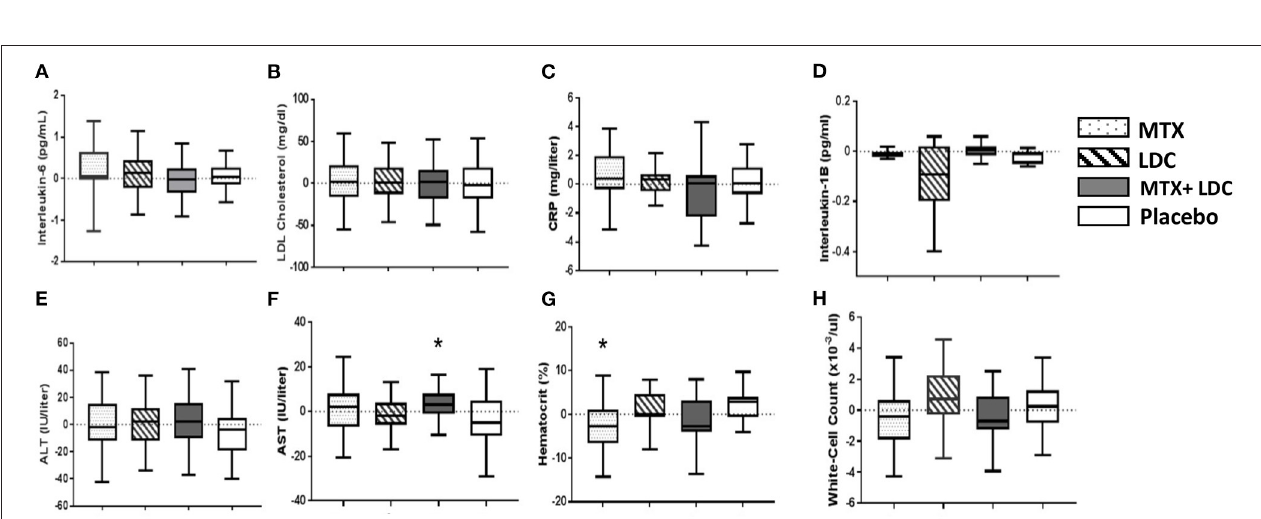
FIGURE 3 | Bar graphs showing the effects of low-dose methotrexate (MTX, dotted bar), colchicine (LDC, striped bar), the combination of MTX and LDC (gray bar), and placebo (white bar) on (A) . interleukin-6, (B) low-density lipoprotein [LDL] cholesterol, (C) hsCRP, (D) interleukin-1 β , hepatic enzyme levels (E) alanine aminotransferase [ALT] and (F) aspartate aminotransferase [AST], and hematologic measures (G) hematocrit level, (H) white-cell count. Data shown are the changes from study enrollment to 8 weeks after randomization. The horizontal line in each box represents the median, the top and bottom of the boxes represent the interquartile range, and the whiskers represent 1.5 times the interquartile range. *Statistically significant difference ( P ≤ 0.05) compared to placebo.